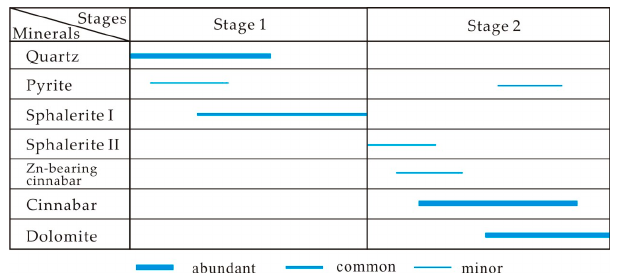
Figure 5. Paragenetic diagram of the Chashula Hg – Zn deposit.